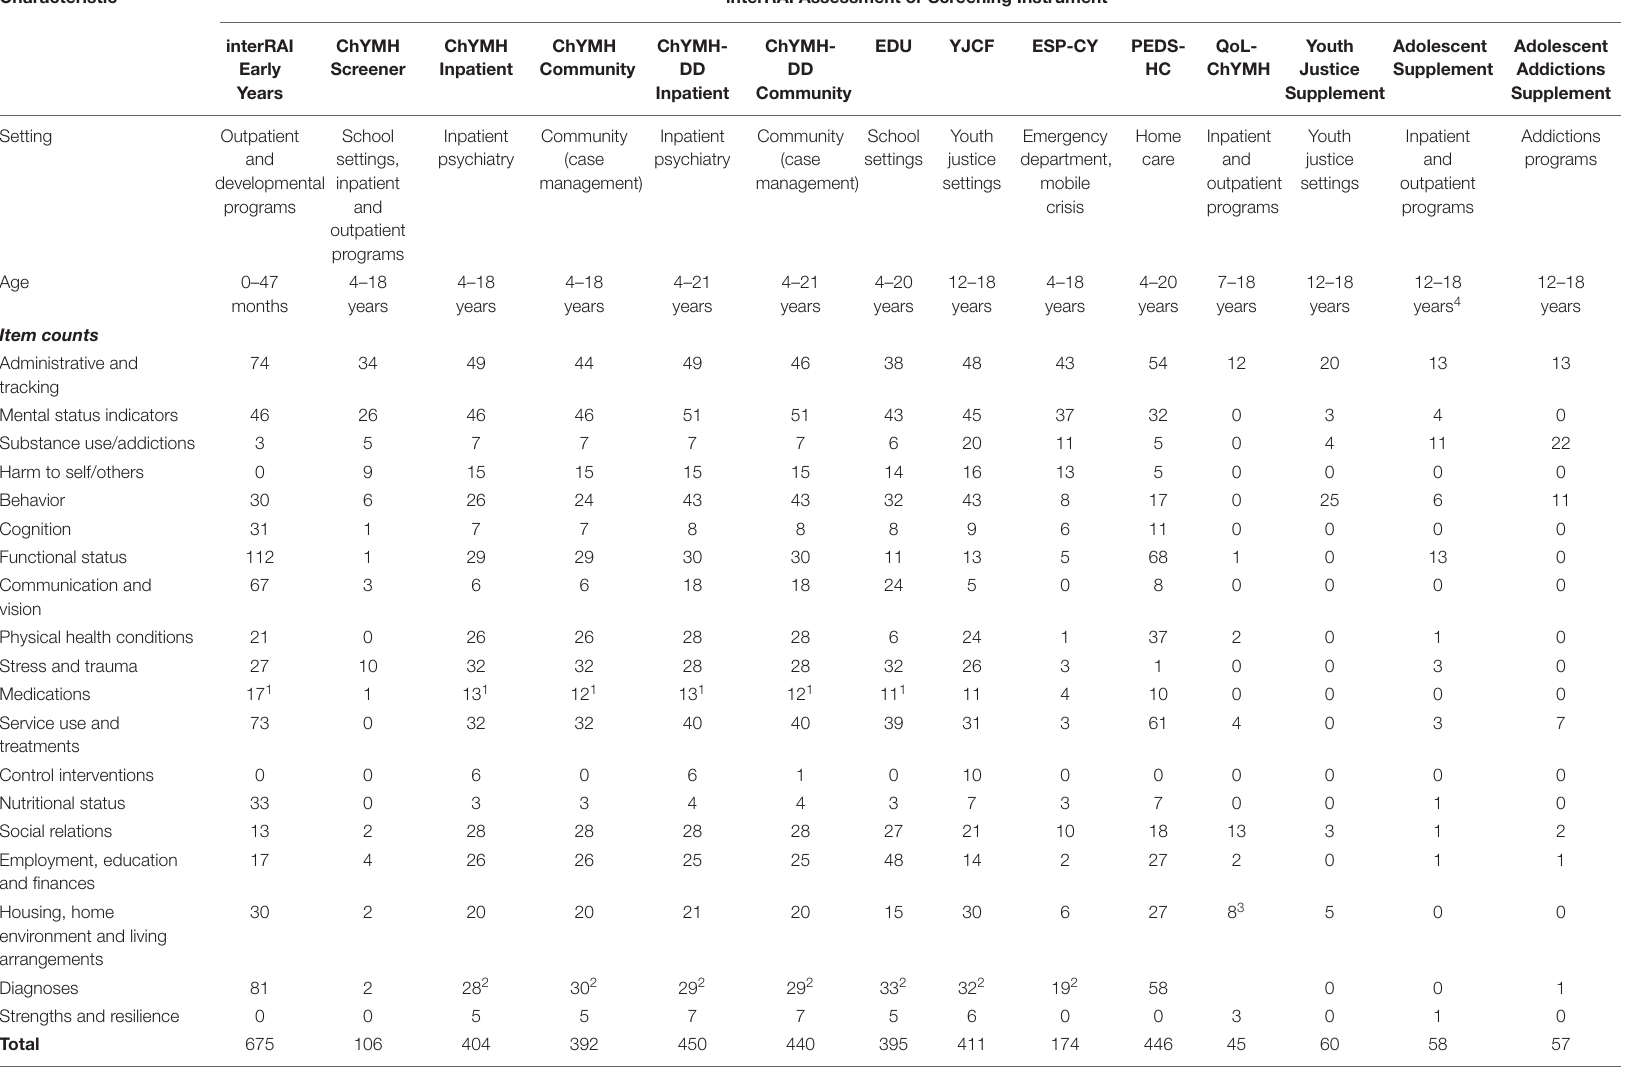
TABLE 1 | Item counts by domain area and interRAI mental health system for child/youth populations (ages 0–18).